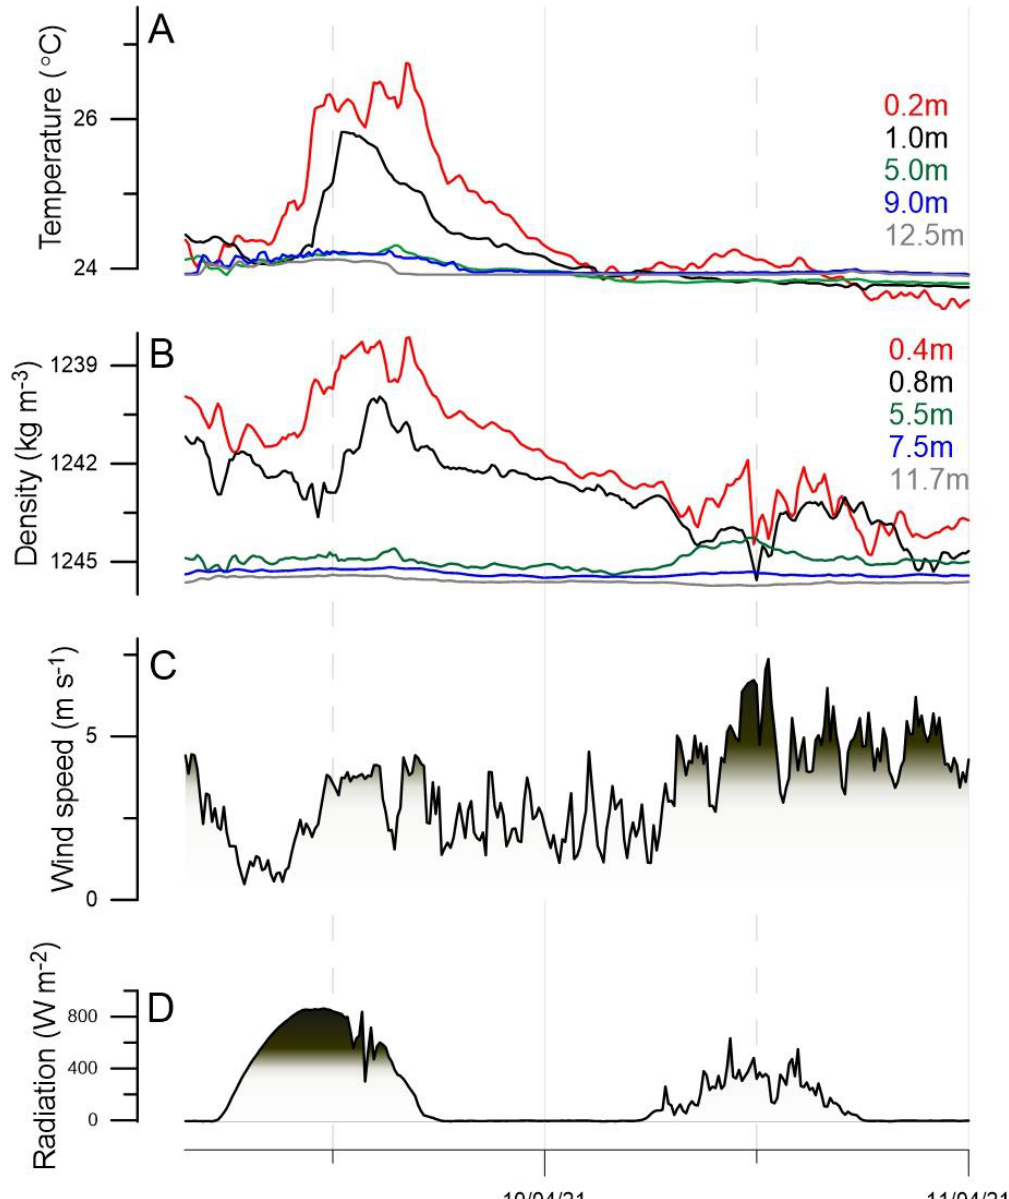
Figure 8. Time series of the stratification of the diluted plume. Temperature ( A ) and density ( B ) variations with depth. Atmospheric forcing: wind speed ( C ) and solar radiation ( D ). Wind speed above 4 m · s − 1 is highlighted, as this is the threshold for wind-wave mixing.